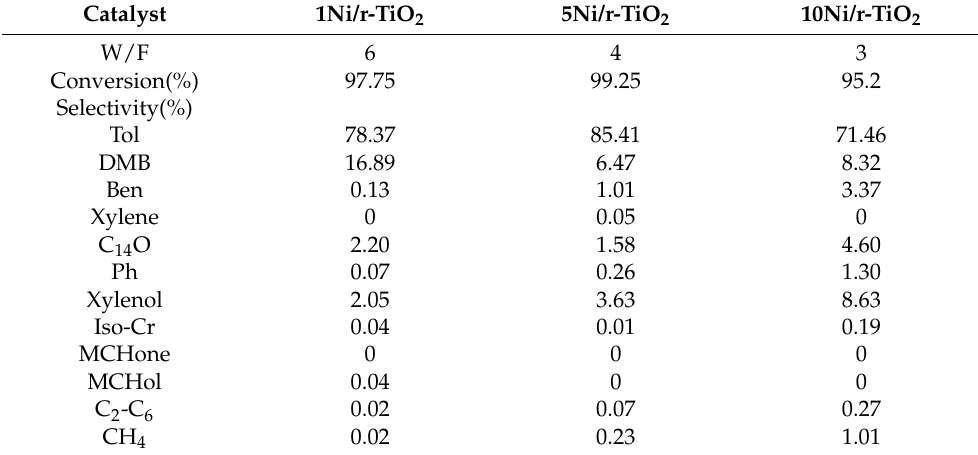
Table 4. Product yields at near-complete conversion of m-cresol over 1Ni/r-TiO 2 , 5Ni/r-TiO 2 , and 10Ni/r-TiO 2 .